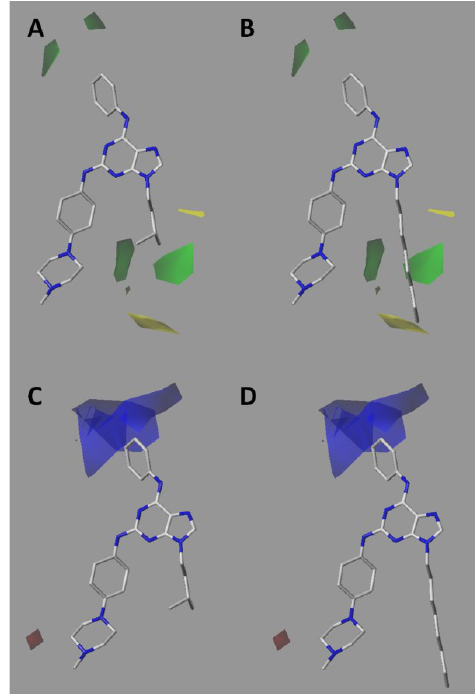
Figure 7. Steric ( A , B ) and electrostatic ( C , D ) contour maps in FLT3-ITD. The most active compound 5a ( A , C ) is compared against the least active 5j ( B , D